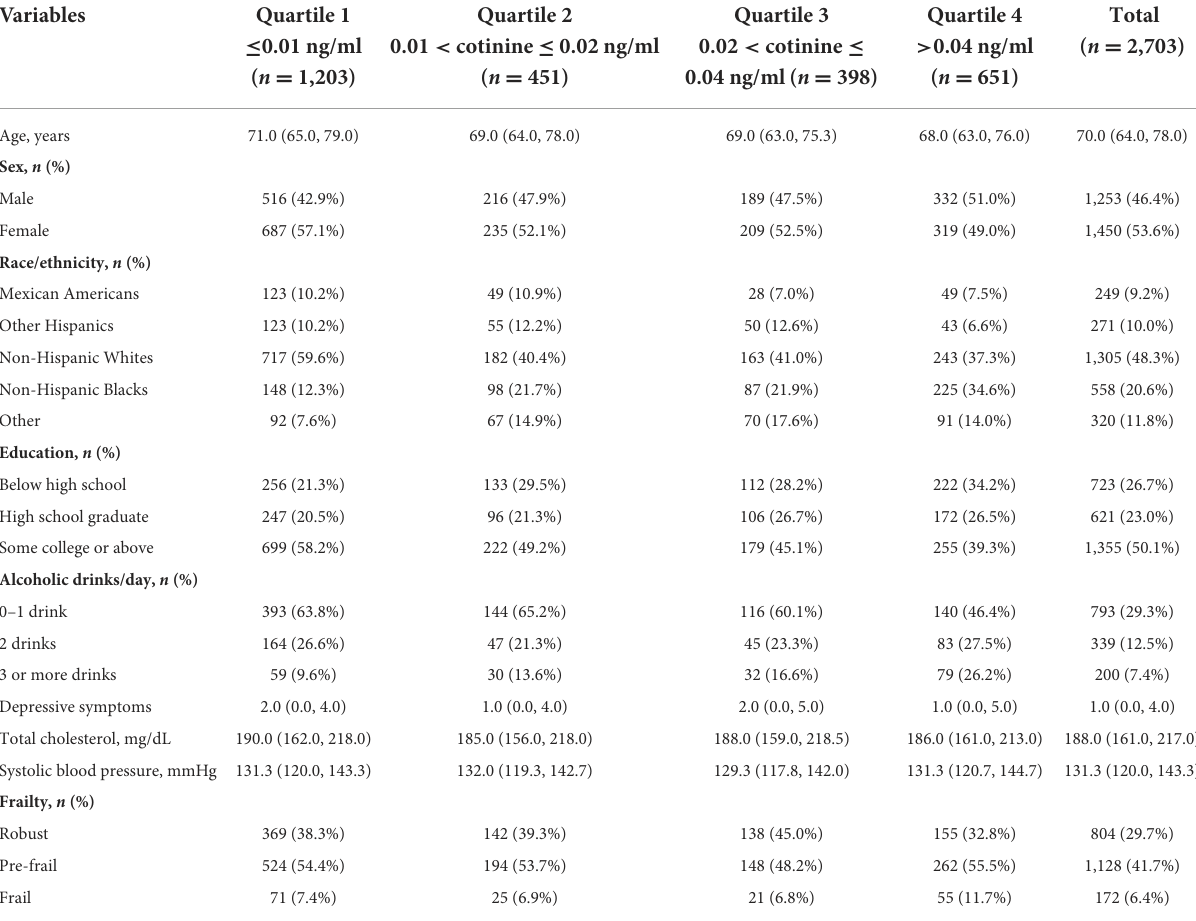
TABLE 1 Characteristics of the participants by serum cotinine level